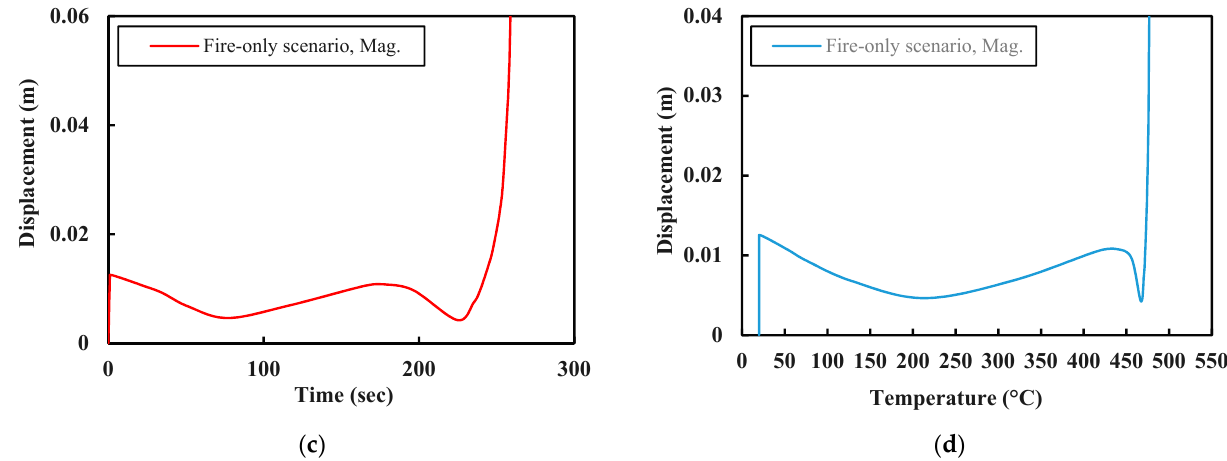
Figure 9. Results from the fire-only analysis of the steel framed structure including ( a ) the time-mid-span displacement; ( b ) the temperature-mid-span displacement; ( c ) the time-mid-span displacement data for the total displacement, and ( d ) the temperature-mid-span displacement record for the total displacement.